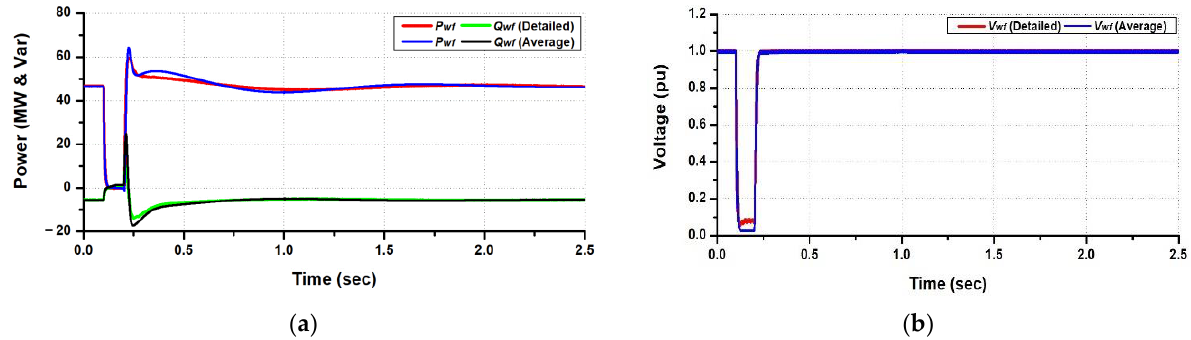
Figure 23. Power output and voltage performances of the wind farm at Bus B33 under the 3LG case: ( a ) Active power output of wind farm; ( b ) Voltage profile at Bus B33.